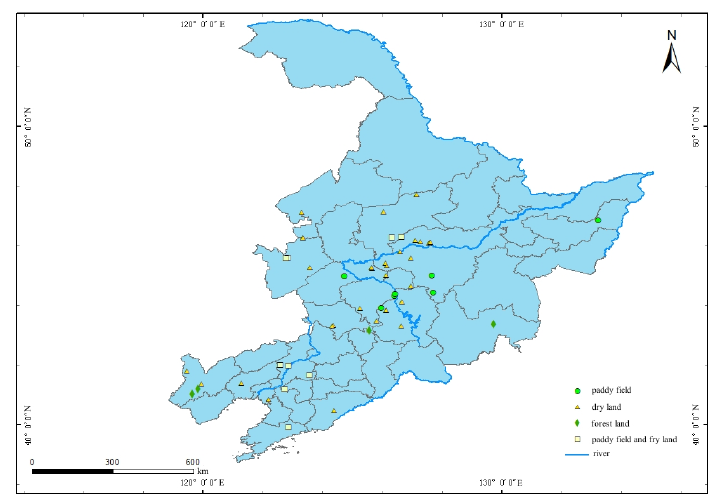
Figure 3. Sample points and division of regions.